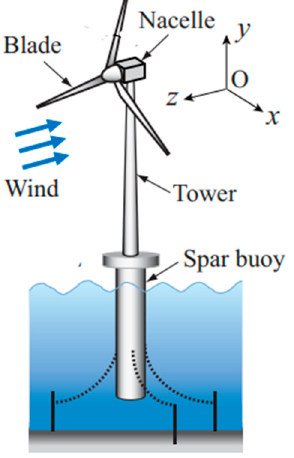
Figure 2. Spar-type floating offshore wind turbine [21].